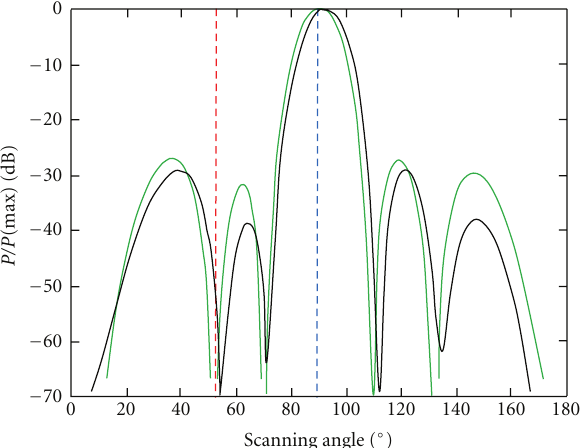
Figure 10: The ANN beam pattern received with 20 neurons in the hidden layer—the beam pattern setting to zero on the interference direction.